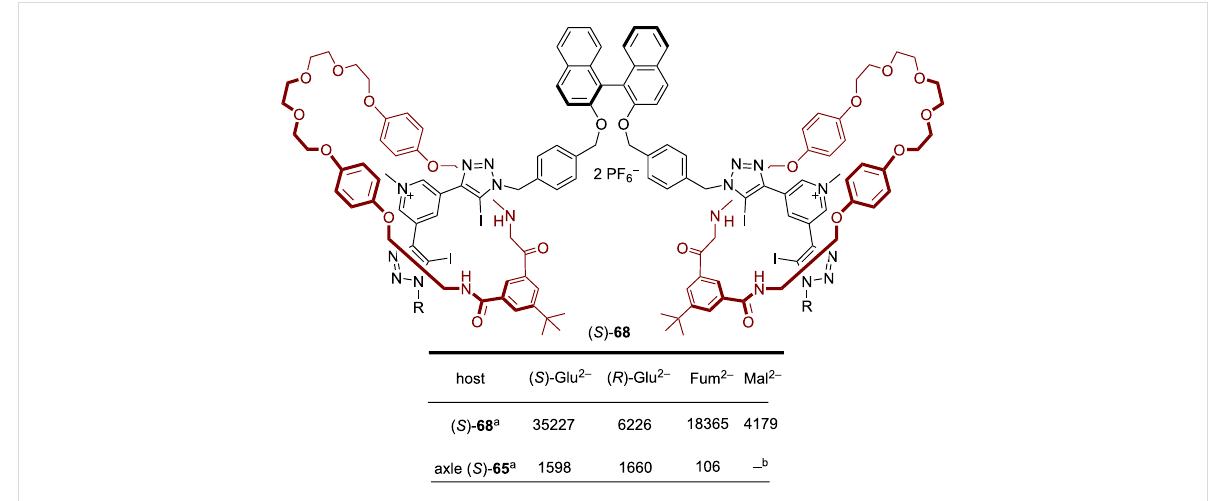
Figure 19: Association constants of different anions (used as the Bu 4 N + -salts) to the [2]rotaxane ( S )- 68 and axle ( S )- 65 . Only the first association constant ( K 11 ) is given. a In CHCl 3 /CH 3 OH/H 2 O 60:39:1. b Complex equlibria, no association constant